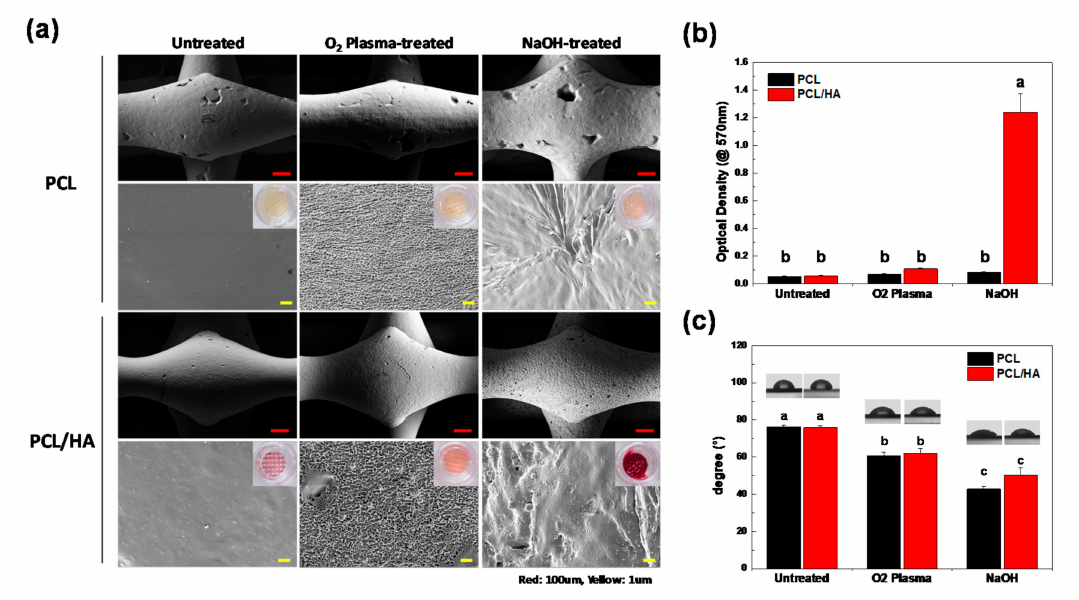
Figure 2. ( a ) FE-SEM image of the PCL and PCL/HA scaffolds before and after surface modification. Alizarin Red S staining was used to visualize the existence of hydroxyapatite on the scaffolds. ( b ) Quantitative data from the Alizarin Red S staining of the scaffolds (n = 3, ANOVA, Duncan’s multiple range test, p < 0.05). Same letters indicate that there is no significant difference between samples. ( c ) Water contact angle analysis of the scaffolds (n = 5, ANOVA, Duncan’s multiple range test, p < 0.05). Same letters indicate that there is no significant difference between